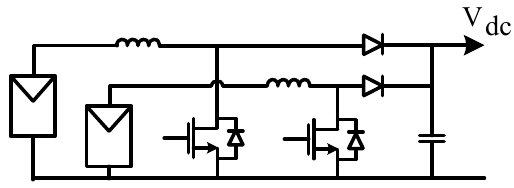
Figure 30. Multiple-input boost substring converter.